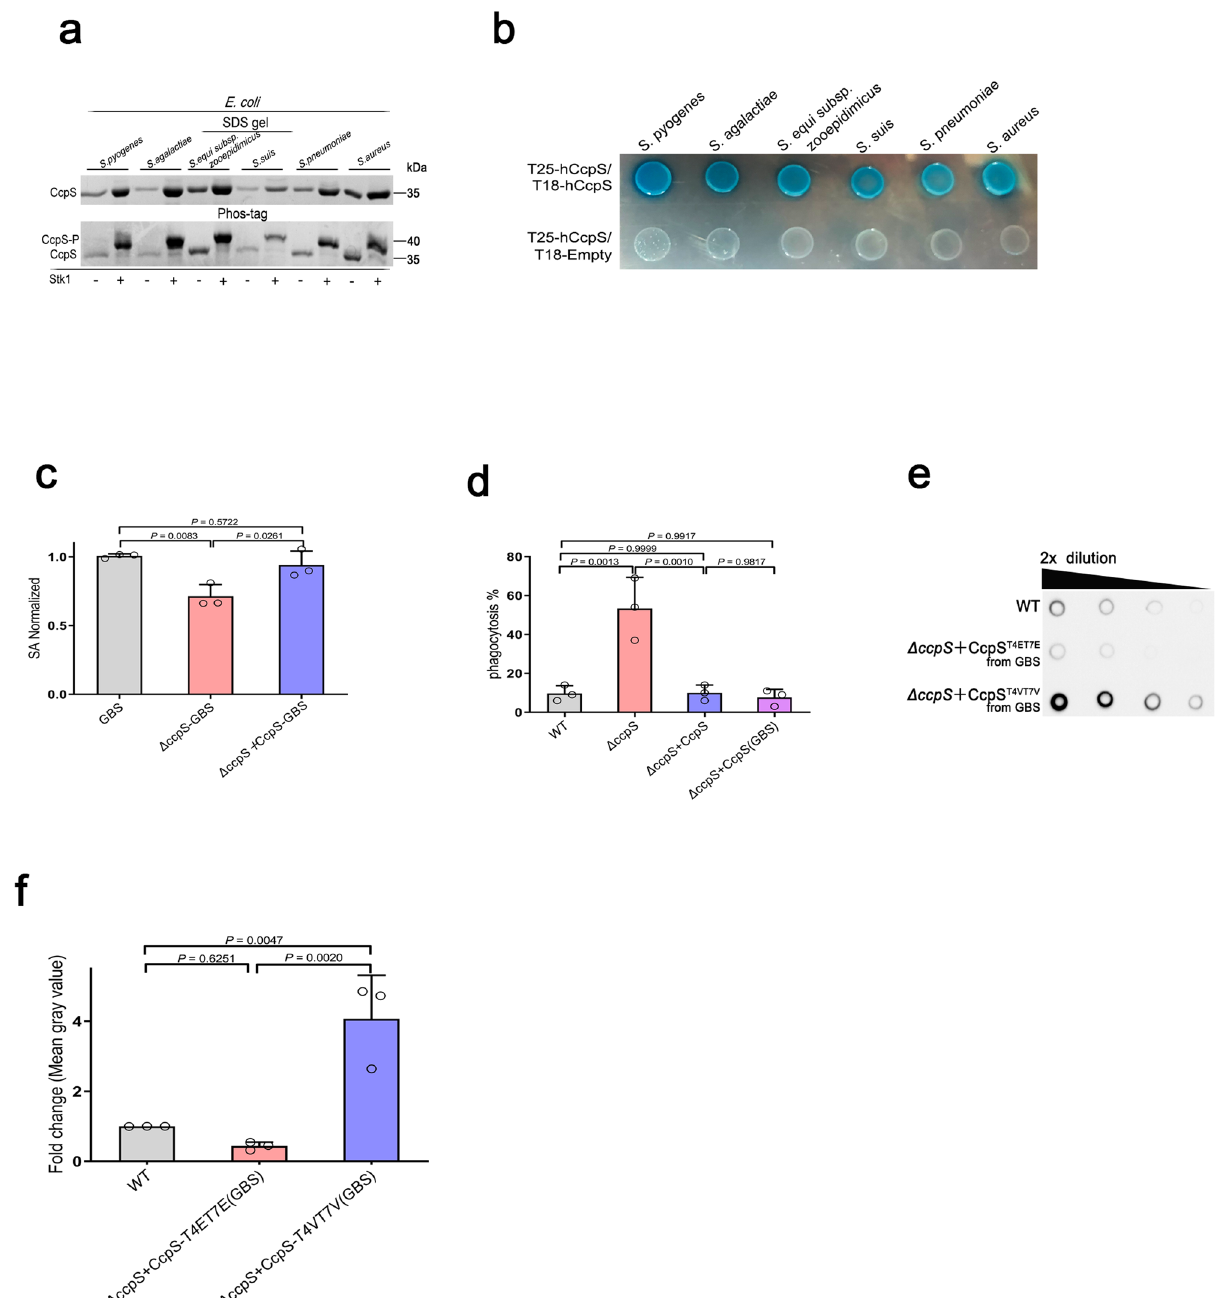
Fig. 7 | CcpS phosphorylation-modulation mode constitutes a widespread mechanism of signal transduction and regulation in Gram-positive bacteria. a The homologous CcpS-GST proteins were expressed in E. coli in the absence or presence of S. suis Stk1, GST agarose beads were used to pull down homologous CcpS-GST and the samples were loaded onto Phos-tag gel to analyze the phos- phorylation of CcpS homologs, samples were also loaded onto a standard SDS gel and Coomassie stain. For this experiment, CcpS and its homologs from Strepto- coccuspyogenes,Streptococcusagalactiae,Streptococcusequisubsp.zooepidemicus, S. suis, Streptococcus pneumoniae, and Staphylococcus aureus were analyzed. b Bacterial two-hybrid assay testing for self-interactions of CcpS homologs. Blue colonyformationsuggeststhatadirectinteractionoccurs. c Bargraphshowedthe cell surface ’ s sialic acid (SA) levels of S. agalactiae strain A909 (WT) and its deri- vative strains. SA extracted from the cells ’ surface was quanti fi ed by a resorcinol assay. The values were normalized to the WT levels, considered 1. Data represent mean±SD from n =3 biologically independent experiments. d Bacterial